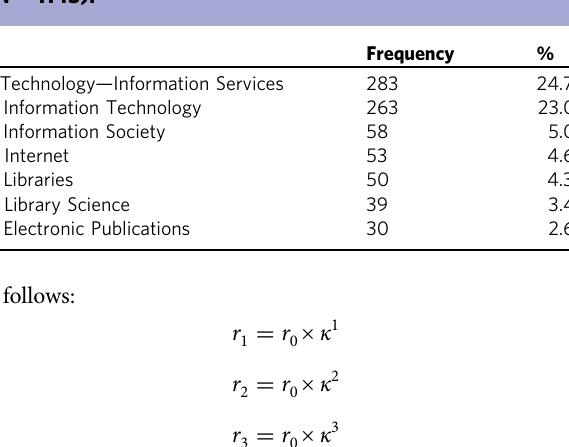
Table 3 Core subject terms in ICT research, 2003 –